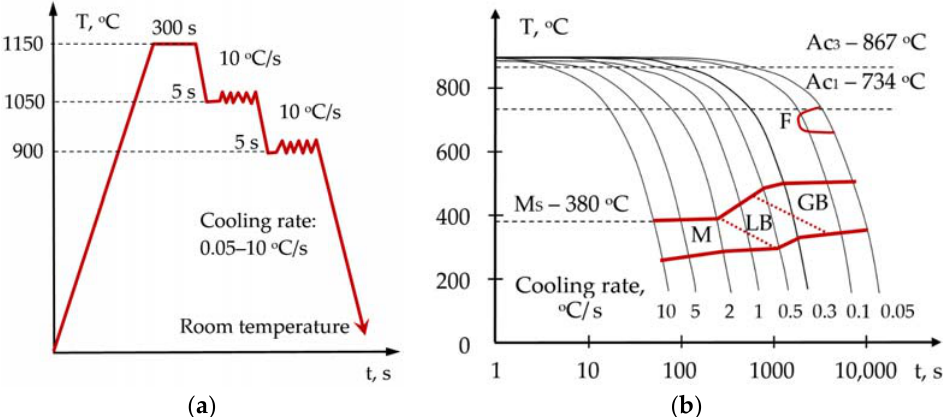
Figure 11. ( a ) TMCP and ( b ) CCT diagram of CFB steel. Data from [58].